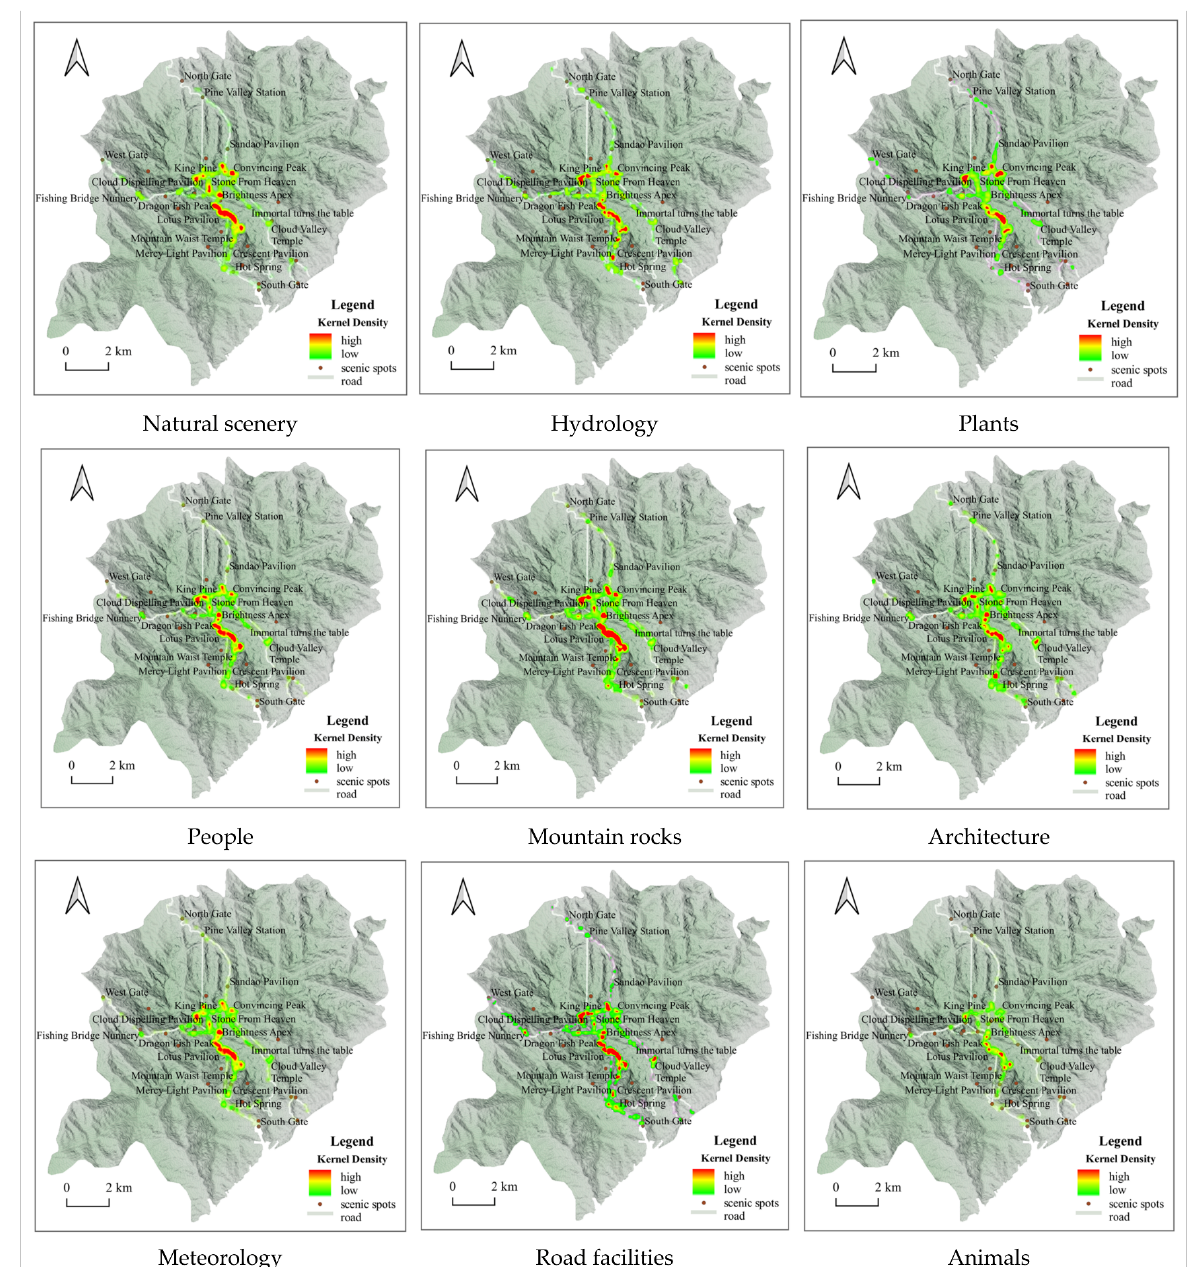
Figure 4. Kernel density analysis of landscape types of photographic interest to